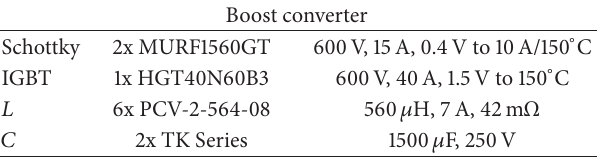
Figure 21: System block diagram. Table 2: Boost converter